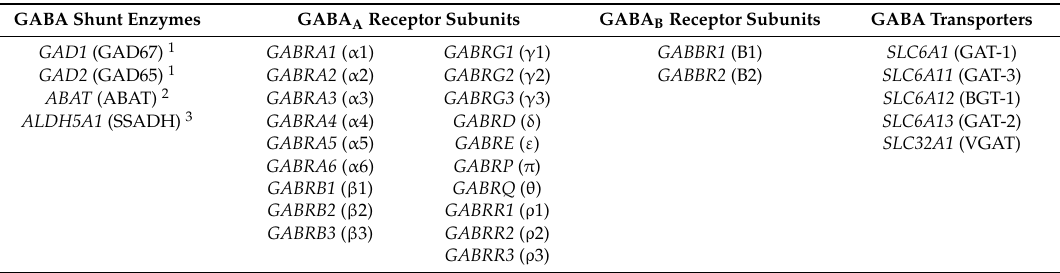
Table 1. Genes encoding GABA system proteins.